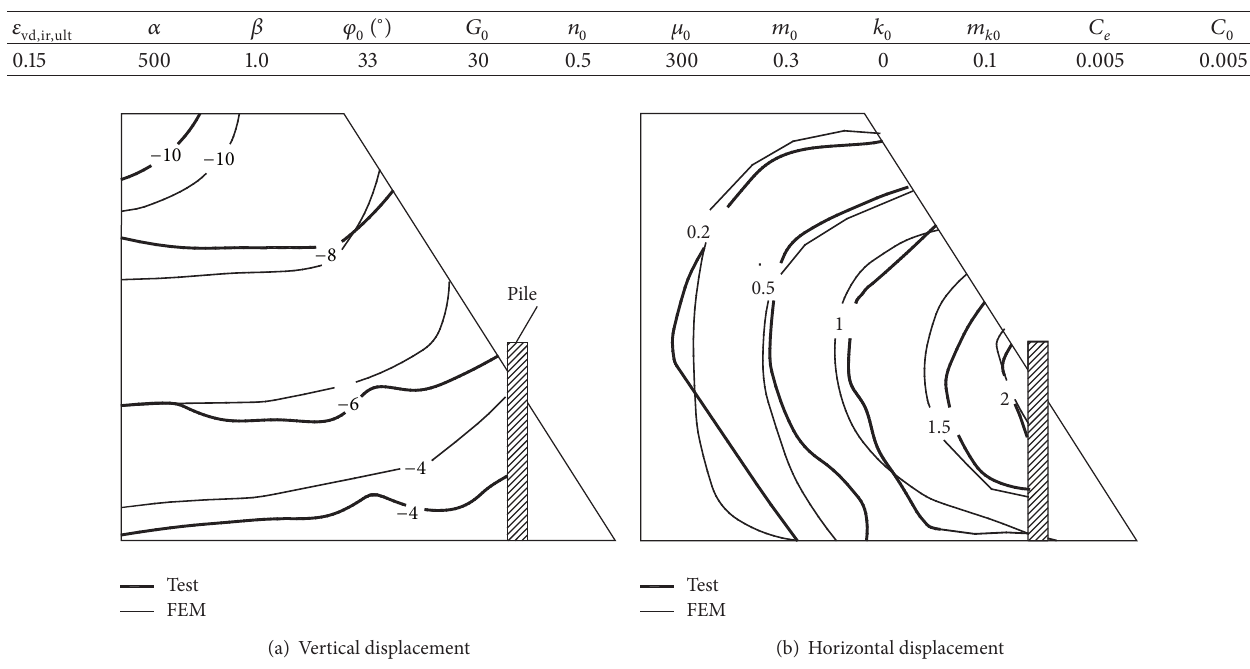
Figure 4: Displacement distribution comparison of numerical analysis and test results (unit: